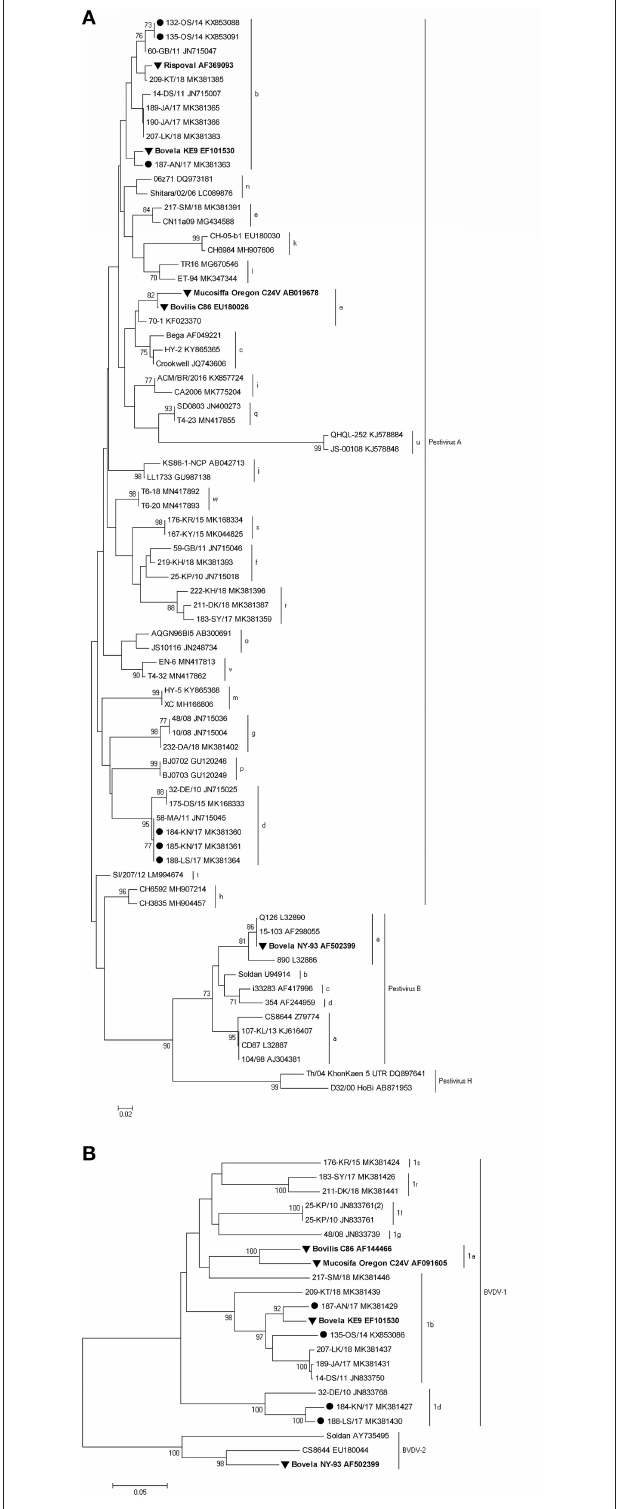
FIGURE 3 | Phylogenetic trees based on the partial (A) 5 ′ UTR and (B) N pro sequences obtained from vaccinated herds. Strains reported in this study are marked with a black circle, and vaccine strains are labeled in bold and marked